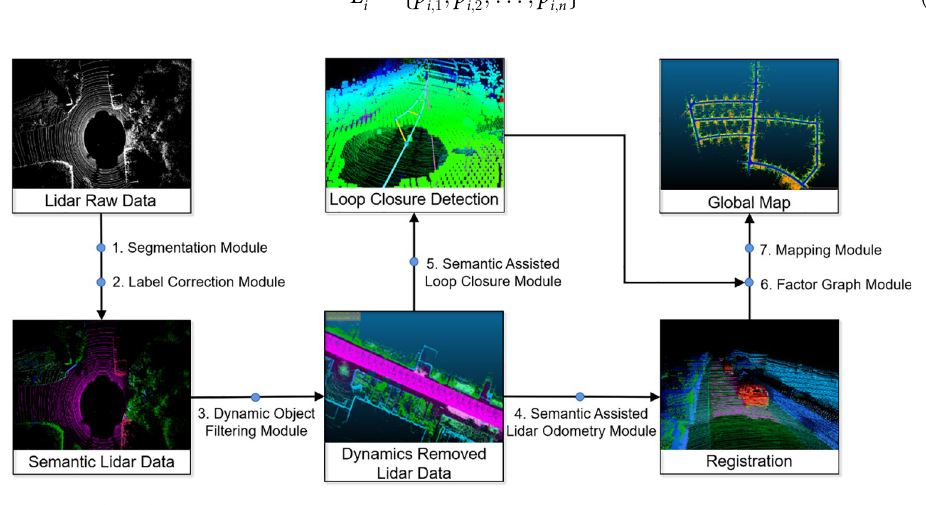
Fig 1. Pipeline of